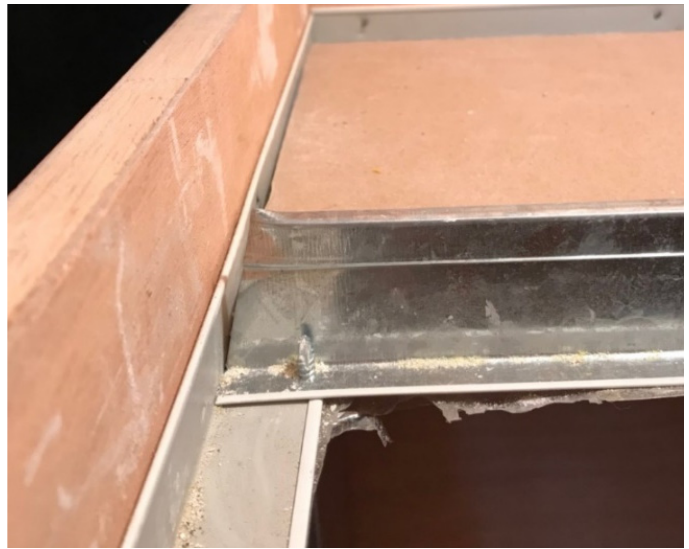
Figure 15. Intersection of frame and trim after